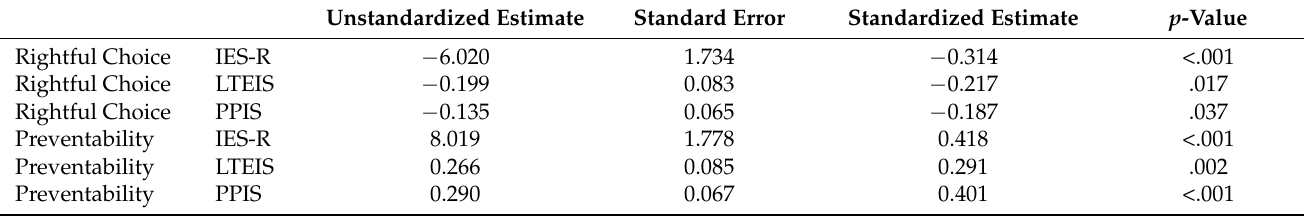
Figure 1. Path analysis for the short-term (IES-R), long-term emotional (LTEIS), and long-term professional (PPIS) impacts of client suicide, as predicted by the ATTS-18. Table 2. Regression weights for the ATTS-18 predicting short- and long-term outcomes of client suicide.